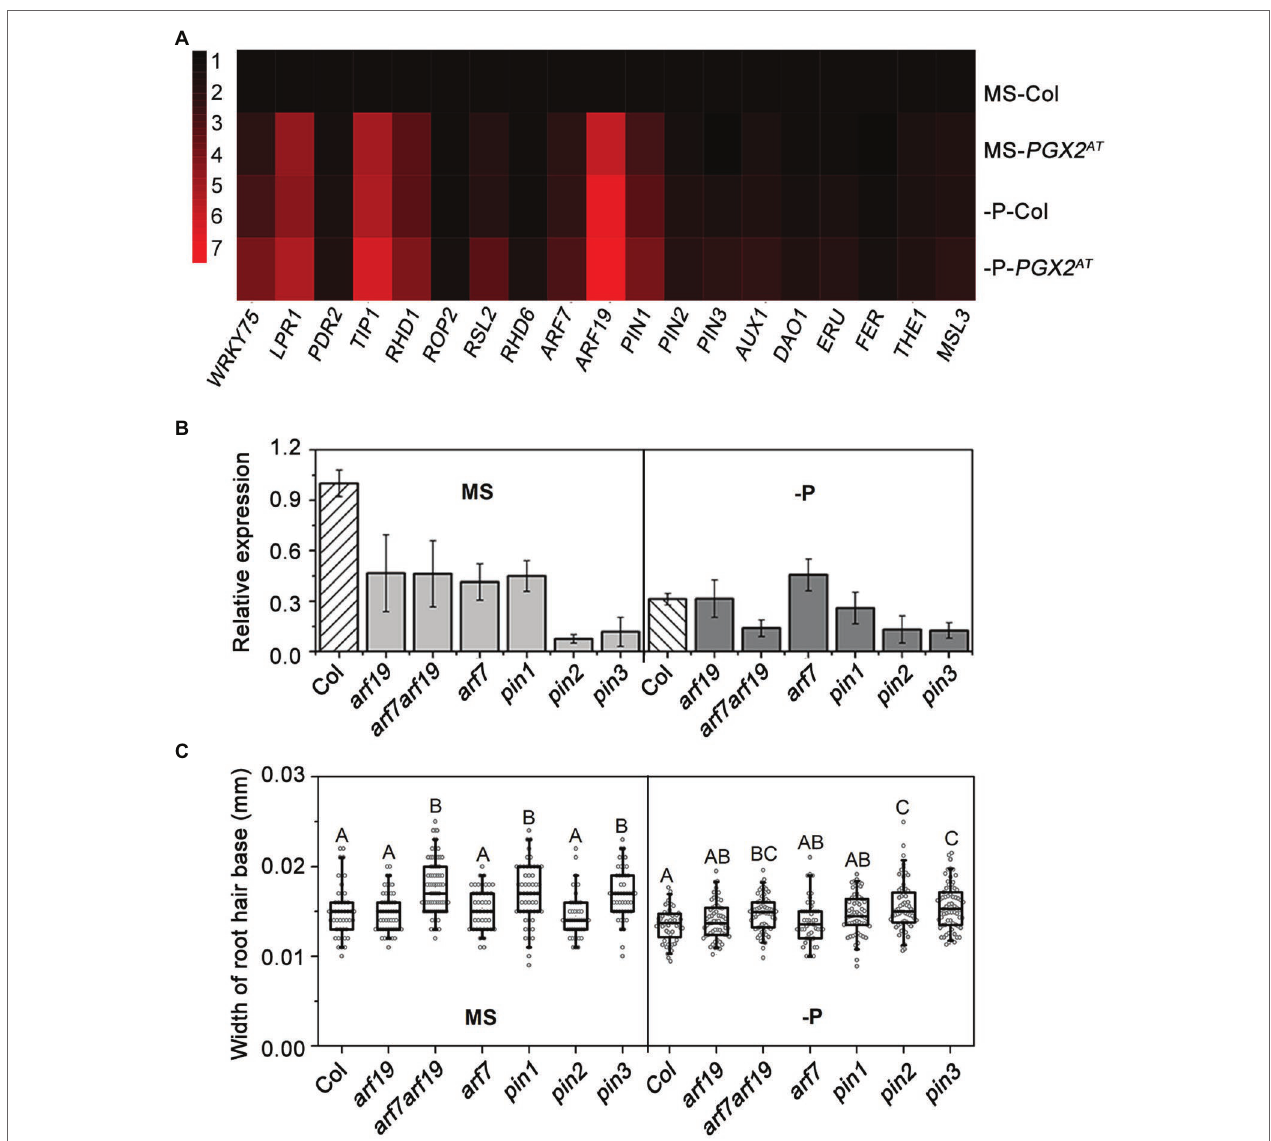
FIGURE 3 | Relative gene expression level and width of root hair base. (A) Relative expression of genes related to phosphate deficient response, root hair development, auxin and cell wall integrity signaling by RT-qPCR in Col, and PGX2 AT seedlings ( n = 3 technical replicates). (B) Relative gene expression level of PGX2 in auxin-related mutants with phosphate deficient (-P) conditions compared to MS controls ( n = 3 technical replicates). (C) Widths of root hair bases of auxin-related mutants grown in MS control and phosphate deficient (-P) conditions ( n ≥ 48 root hairs). All data were collected in seedlings 4 days after transfer. Uppercase letters on top of boxplots indicate significantly different groups as determined by one-way ANOVA with post-hoc Duncan’s test ( p <